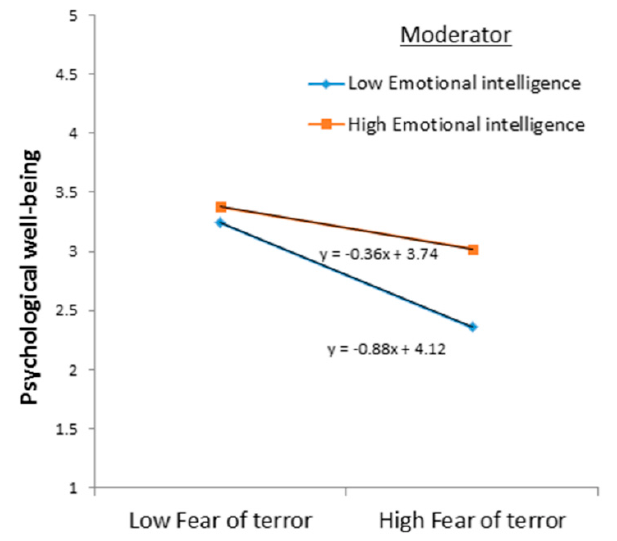
Figure 2. Graphical representation of the moderator emotional intelligence on the association between the fear of terror and psychological well-being.